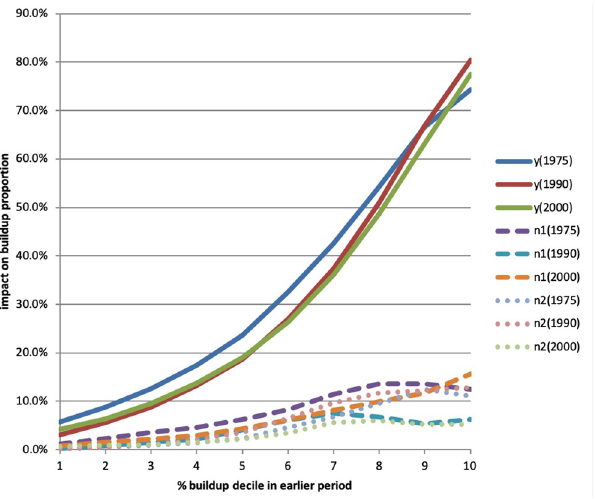
Fig 7. Fig 7 summarizes the coefficients from three separate regressions. The dependent variable in the three regressions is the proportion of a cell that is built up in 1990, 2000, and 2014 respectively. Each regression includes lagged values of buildup in the cell and in the neighboring cells n1 and n2. The lagged values are for 1975, 1990, and 2000 respectively. Each of the three lagged buildup variables appears in the regression as a series of 10 dummies, one per buildup decile. The Figure shows the estimated decile coefficients in each of the three regressions for (1) buildup in the cell itself [lines y(1975), y(1990) and y(2000)]; buildup in neighboring cells n1 [lines n1(1975), n1(1990), and n1 (2000)]; and buildup in neighboring cells n2 [lines n2(1975), n2(1990), n2(2000)]. Each regression also includes the following time invariant regressors: longitude, latitude, and their product [three variables]; soil humidity and soil quality dummies [six variables]; and dummies for the presence of a water body, a land border, or the sea in the cell, the neighboring cells n1 and the neighboring cells n2, respectively [9 variables]. The number of observations in each regression is just shy of 3.8 million. R-squares are 0.799, 0.845 and 0.796, respectively. All coefficients shown here are significant at the 1% or